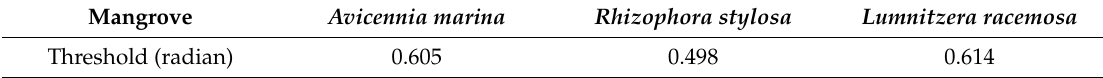
Table 2. The threshold value of each endmember determined by the histogram of a rule